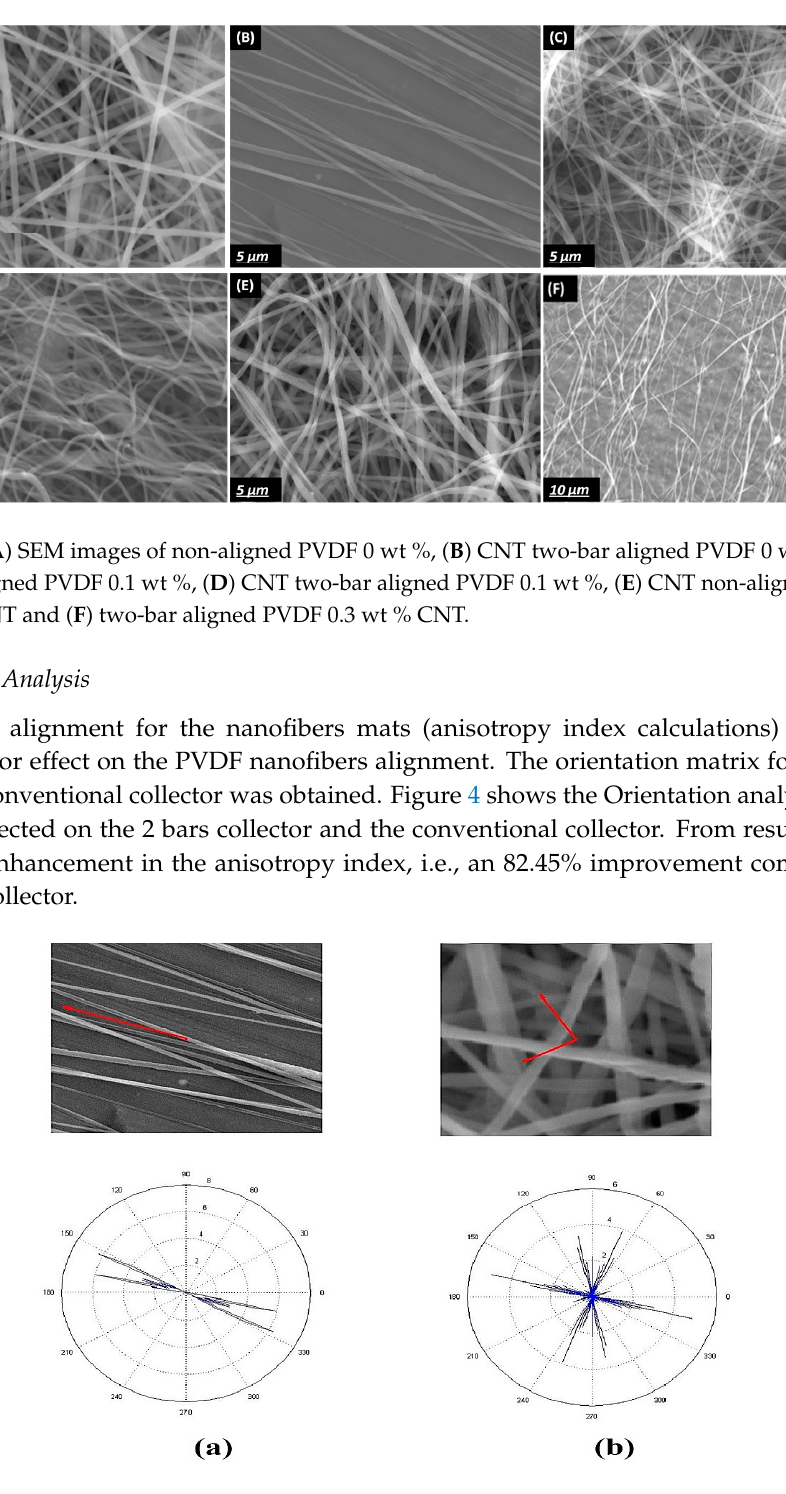
Figure 4. Orientation analysis for nanofibers collected on ( a ) two-bar nanofiber mat, and ( b ) conventional nanofiber mat.